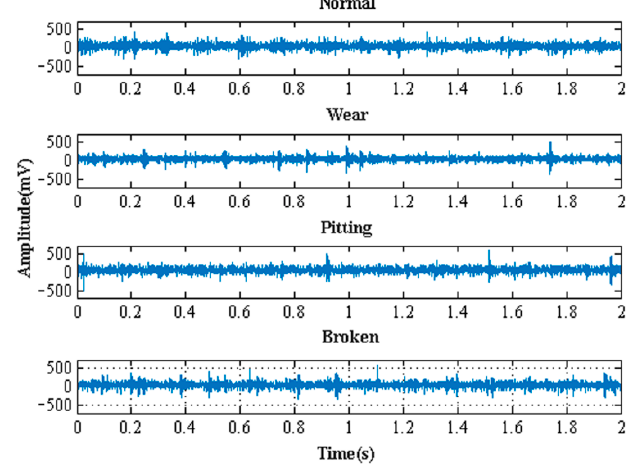
Figure 7. Time − domain diagram of four types of the gearbox vibration data.